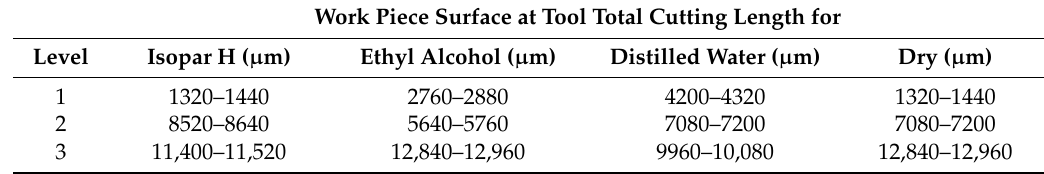
Table 5. Micromilling method and the coolants used in